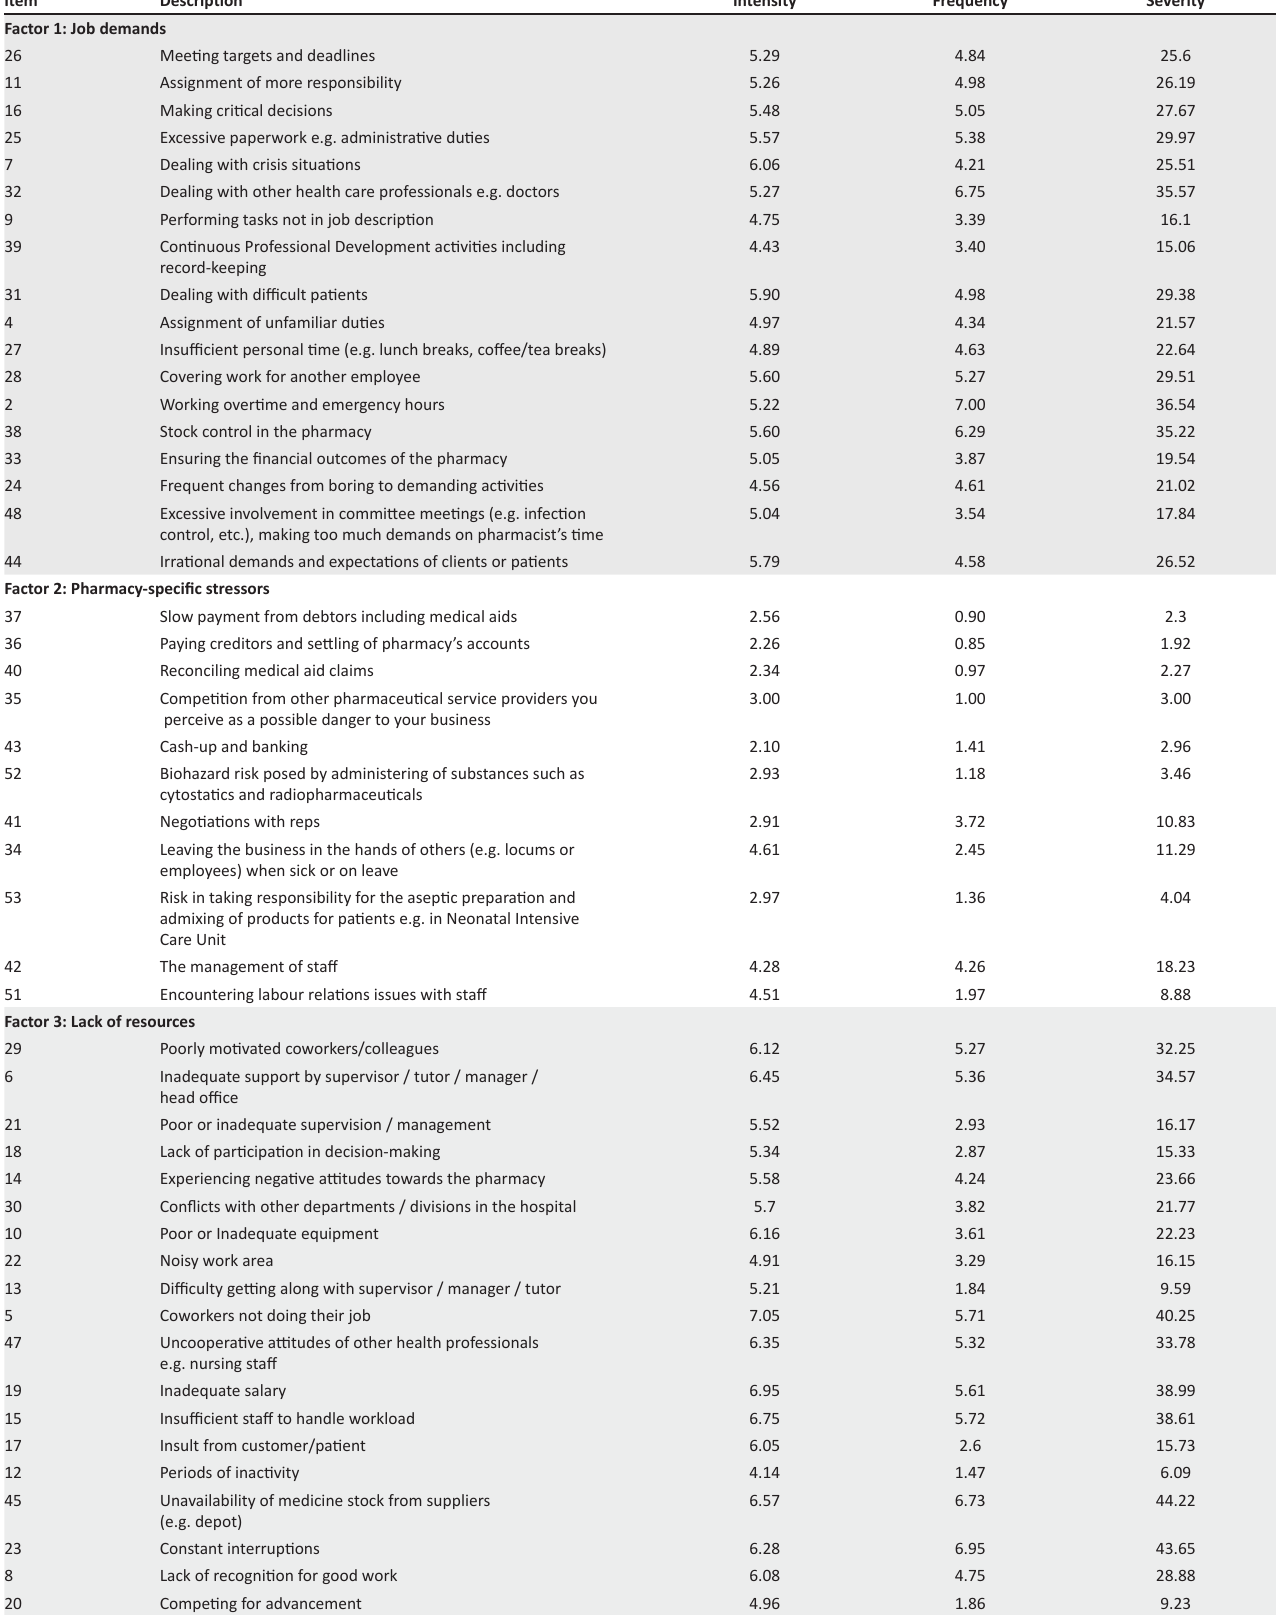
TABLE 3: Intensity, frequency and severity of stressors for